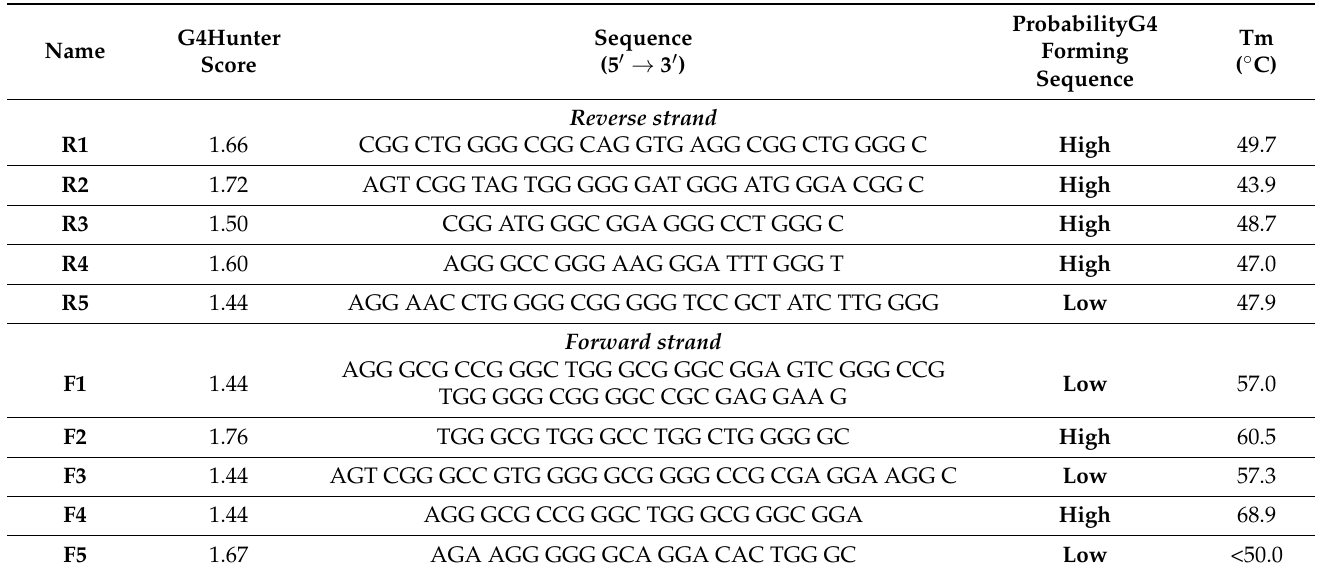
Table 1. All MST1R sequences identified by G4Hunter using a window of 20 nucleotides and a threshold of 1.5 with their corresponding score on both reverse and forward strand. Their capacity to form a G4 as well as their melting temperature have been indicated based on UV-melting experiments at 295 nm in 10 mM potassium phosphate buffer pH 6.6 supplemented with 50 mM